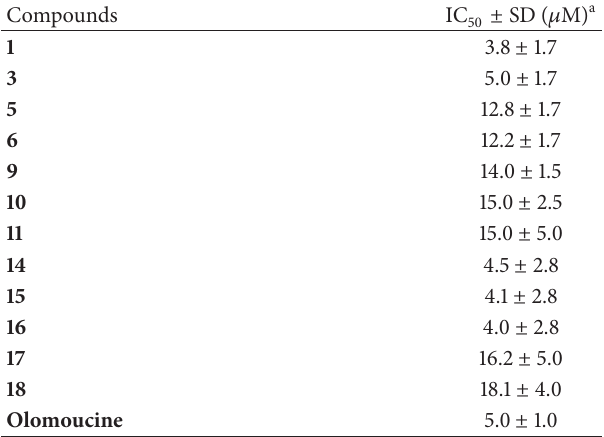
Table 2: CDK2 inhibiting activity of fluorinated 1,2,4-triazinones 1– 18 .